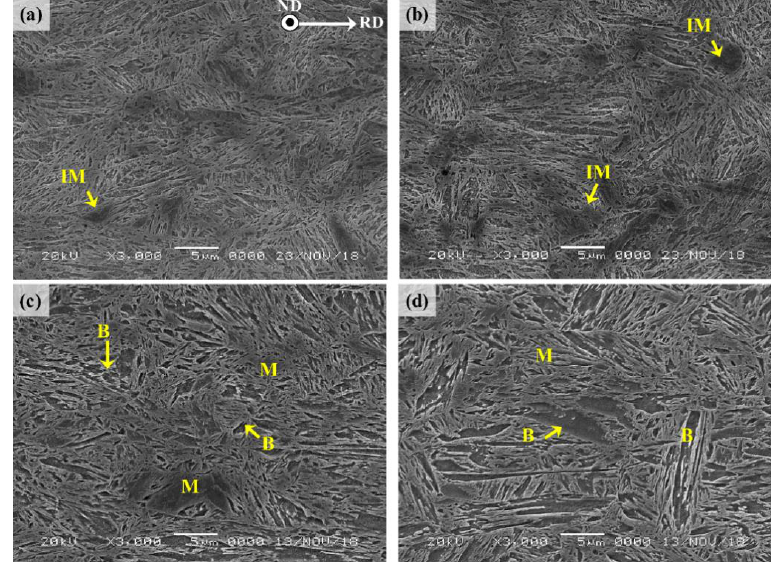
Figure 2. Scanning electron microscope images of the initial microstructures of near surface region: ( a ) alloy A; ( b ) alloy B, and center region: ( c ) alloy A and ( d ) alloy B.